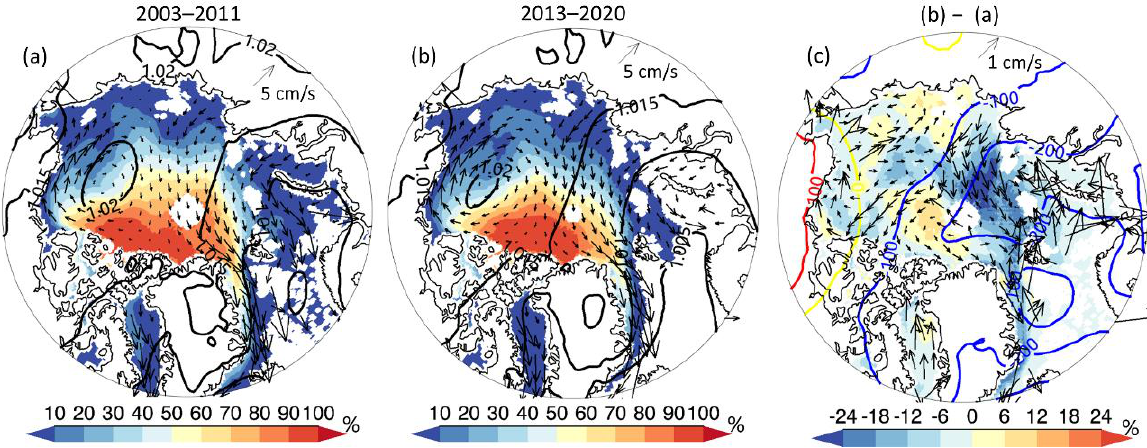
Figure 7. Wintertime composites of MYI concentration (shaded), SIM (vectors), and SLP (contours) during ( a ) D1 and ( b ) D2. The difference between those fields in D1 and D2 is indicated in ( c ). The unit of SLP is 10 5 Pa in ( a ) and ( b ), and Pa in ( c ). The red contours represent positive SLP anomalies, blue contours represent negative anomalies, and yellow contours represent SLP with no difference in ( c ).